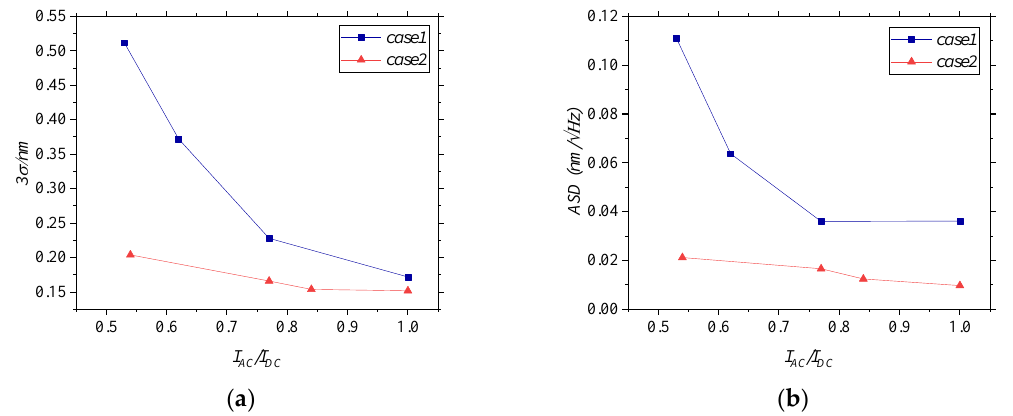
Figure 8. ( a ) The 3 σ of the DE vary with I AC /I DC in different cases. ( b ) The ASD of the DE vary with I AC /I DC in different cases. In case 1, the interference angle is changed. In case 2, the irradiance ratio is changed.